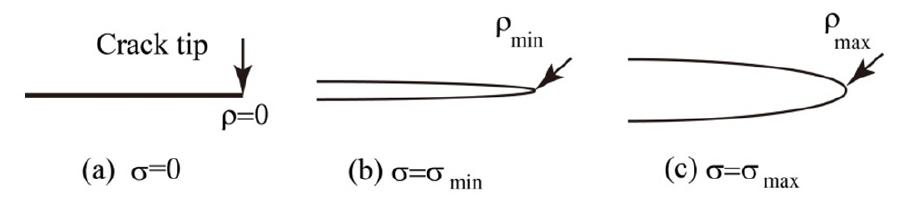
Figure 5: Change of crack-tip radius under loading.